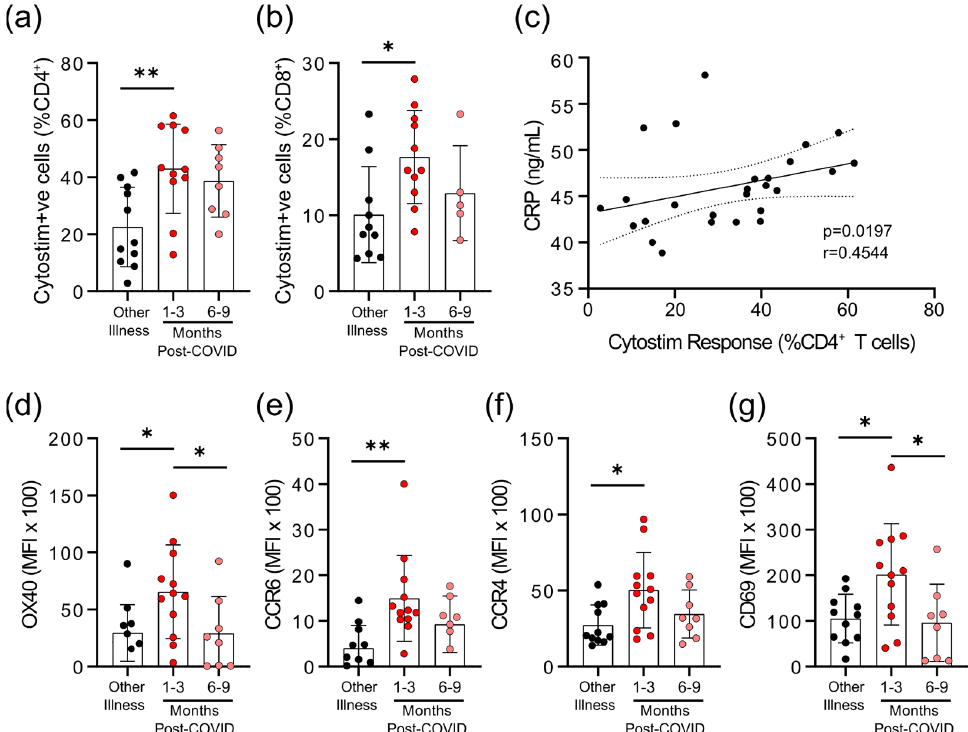
Figure 3. Evidence of prolonged T-cell activation after mild SARS-CoV-2 infection. The polyclonal activator Cytostim was used to measure T-cell responses. COVID-19 seropositive individuals had a higher proportion of CD4 + ( a ) and CD8 + ( b ) activated T-cells 1 to 3 months after infection, compared to seronegative individuals after other respiratory infections. ( c ) The number of CD4 + T-cells that responded to polyclonal stimulation correlated with CRP in COVID-19 seropositive individuals. ( d – g ) Activation markers OX40, CCR6, CCR4, and CD69 on CD4 + T-cells were higher 1–3 months after COVID-19 infection, compared to after other respiratory infections, after Cytostim exposure. Each participant is indicated by a single data point: other respiratory infection n = 7–11; 1–3 months post COVID-19 infection n = 11–12; 6–9 months post COVID-19 infection n = 5–8. Multiple group com- post-hoc test; bars are presented as mean ± standard deviation. Data in C was assessed by Spear- man’s rank correlation. * p < 0.05; ** p < 0.01.